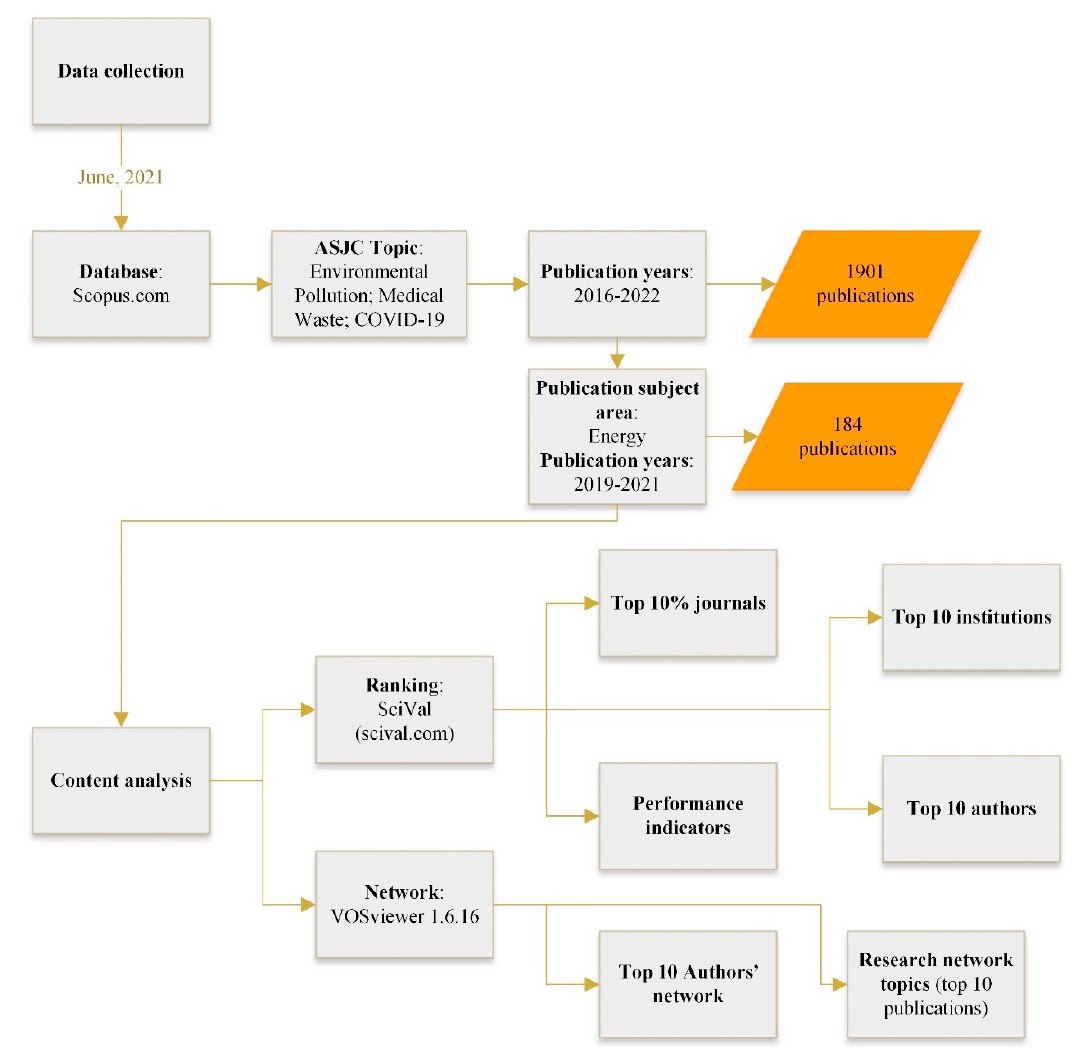
Figure 1. A diagram of the general research methodology.